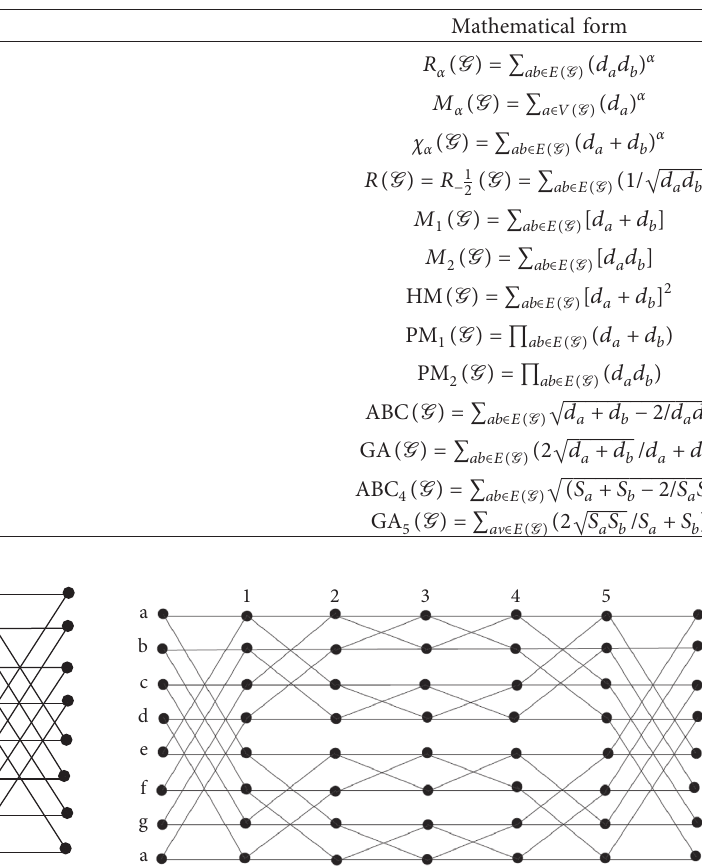
Table 1: Degree-based topological descriptors.